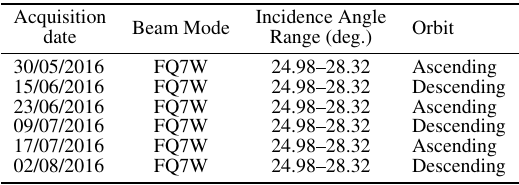
Table 2. Specifications of RADARSAT-2 data